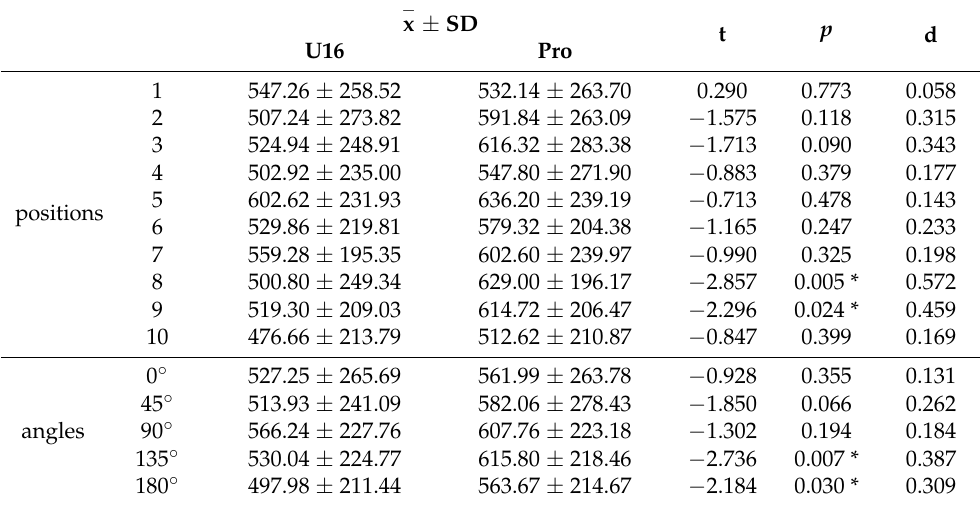
Table 2. Between-group comparison for QE time, according to position and angle (times in